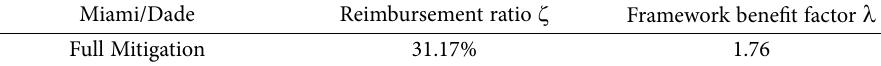
Table 3. Case study result for